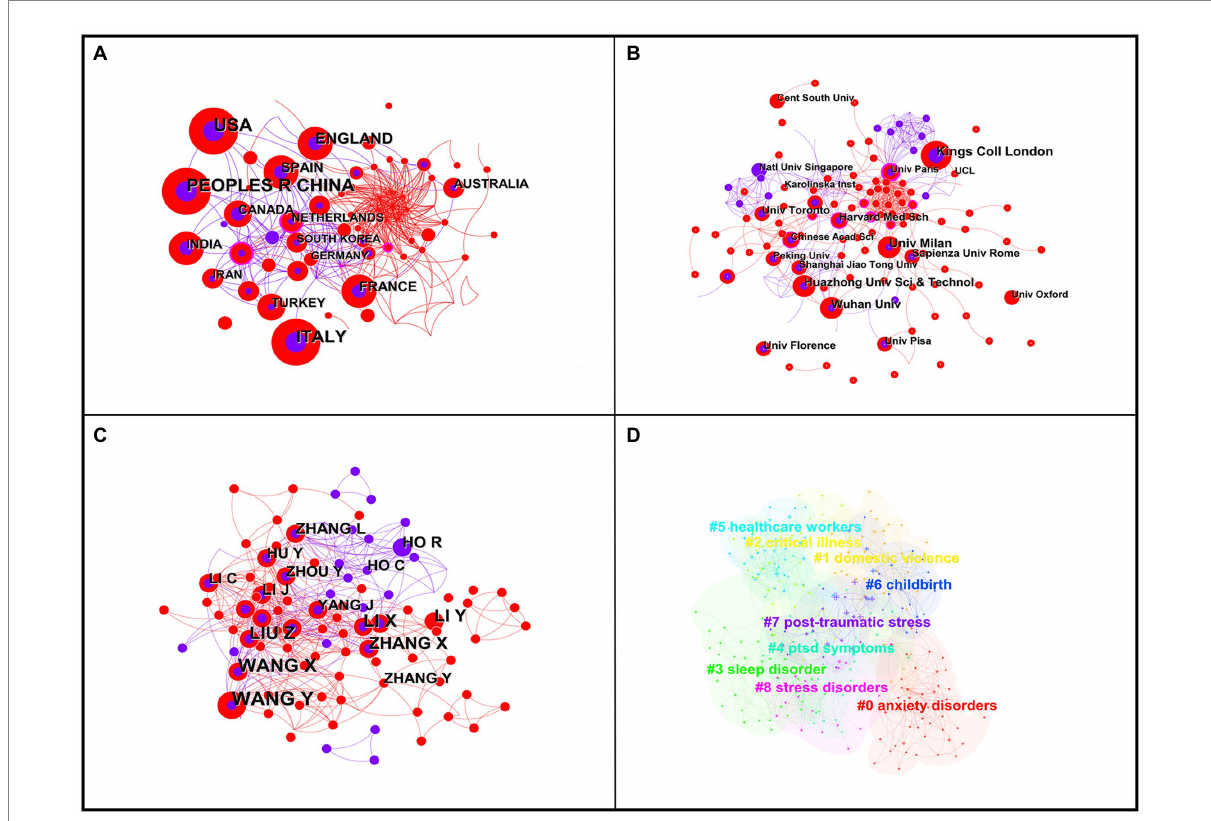
FIGURE 11 The bibliometric analysis of COVID-19. (A) primary countries or regions; (B) primary institutions; (C) prolific authors; (D) keyword